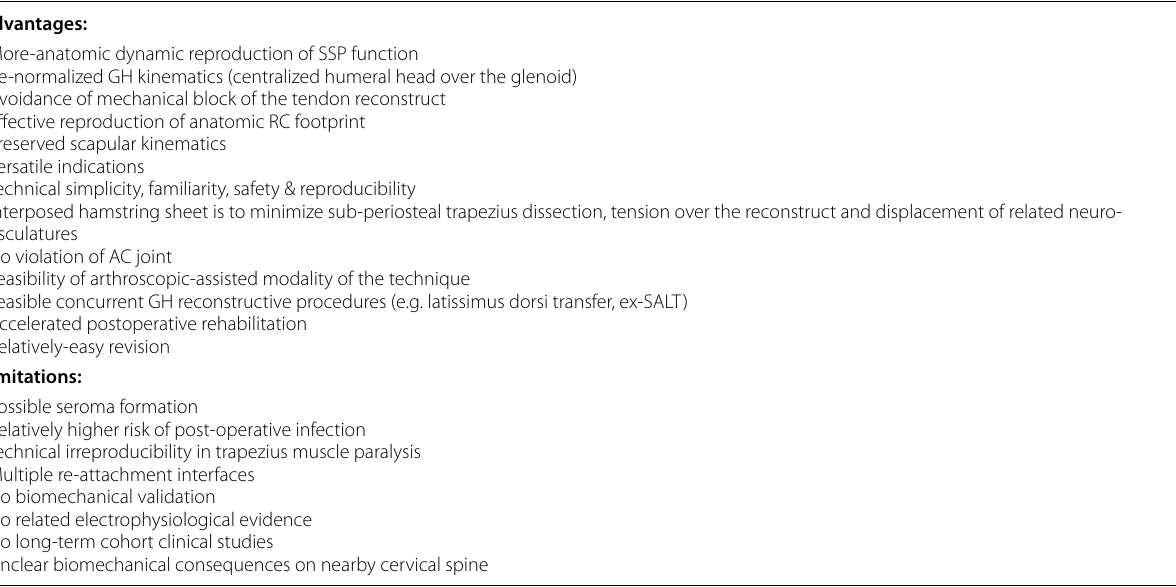
Table 4 Summarizes advantages and disadvantages of currently reported technique of medial trapezius tendon transfer; AC acromio‑ clavicular joint, ex-SALT extra‑articular soft arthroscopic Latarjet technique, GH gleno‑humeral, RC rotator cuff, SSP supraspinatus